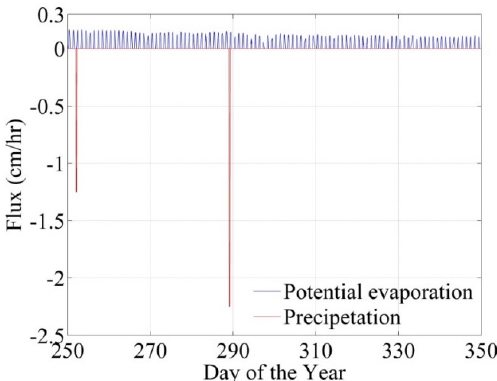
10 of 14 Figure 10. Water level record from a well at a farm (location in Figure 5). Note that one rainfall event was recorded in December of 2014, but water level recovery did not occur for 10 days after the event and began to rapidly recede within a few days. The missing record was caused by the removal of the transducer from the well by the farmer as it was deepened. 3.3. Hydrus Modeling Results Figure 11 shows the precipitation and potential evaporation used for the hydrological simulator, HYDRUS 1-D (public domain free software) as a time-variable top boundary condition. The potential evaporation was calculated using the modified Penman-Monteith equation [24]. Hourly average values of various meteorological variables, including air temperature, relative humidity, wind speed, incoming shortwave radiation, and barometric pressure, were input into the